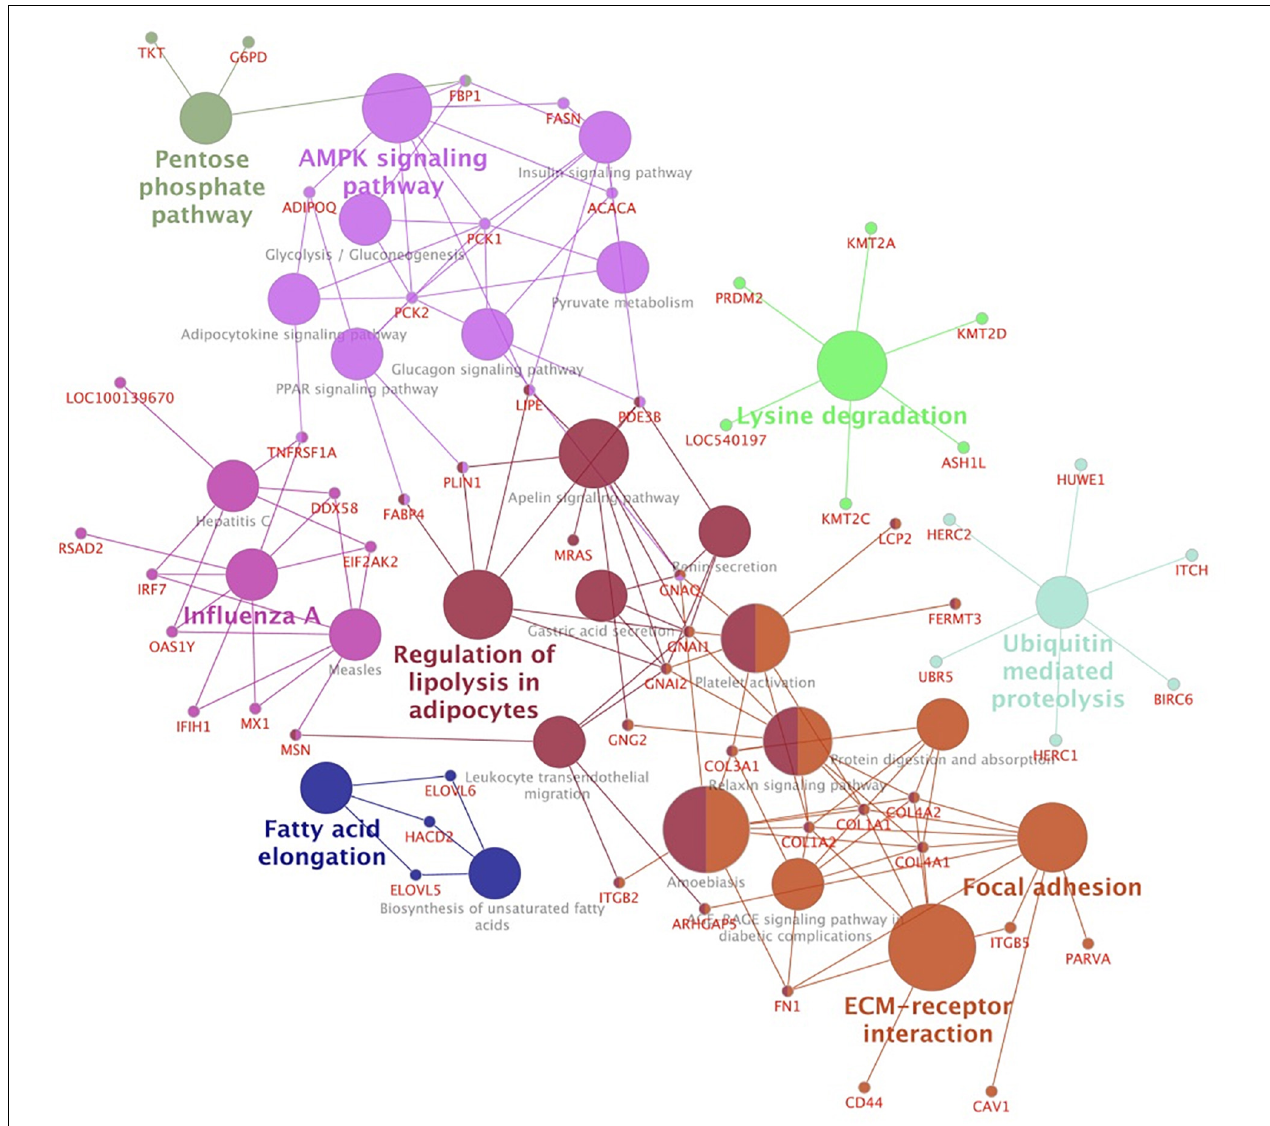
FIGURE 4 | Network clusters based on over-represented KEGG pathways of hub genes associated with mineral concentration and meat quality traits. Functionally related groups partially overlap and are arbitrarily colored. The node size represents the pathway enrichment